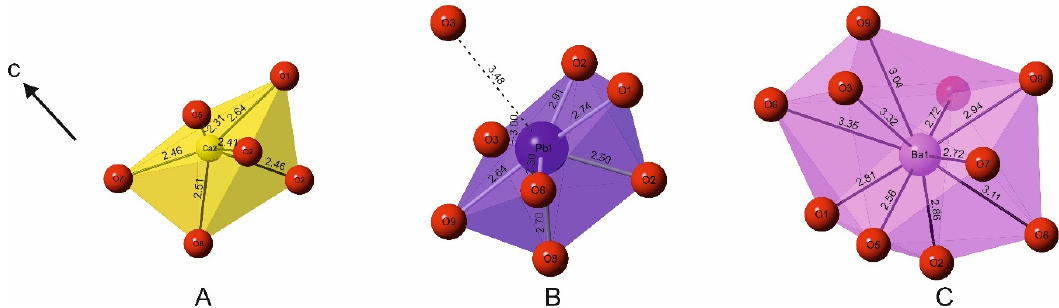
Figure 7. Polyhedra geometry Ca2 in breyite ( A ), Pb1 in margarosanite ( B ) and Ba1 in walstromite ( C ).